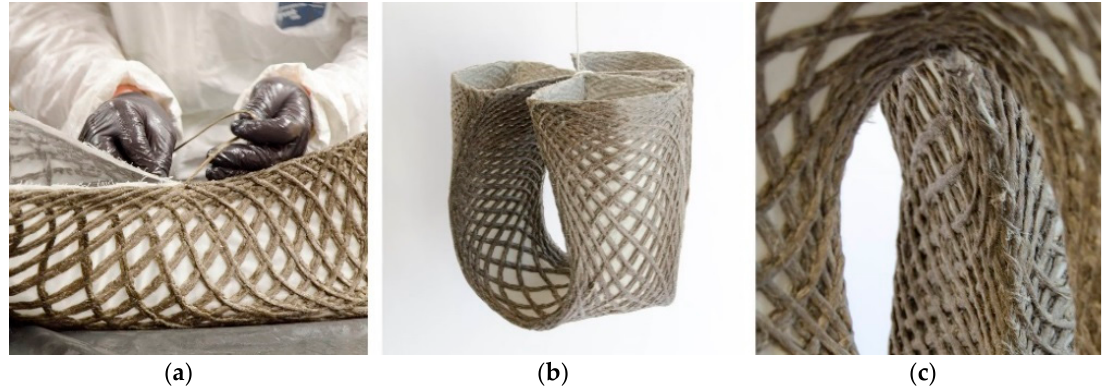
Figure 12. Stitching of the legs ( a ) and forming of preform under self-weight ( b ). Closeup photography of the stitched legs after curing ( c ).